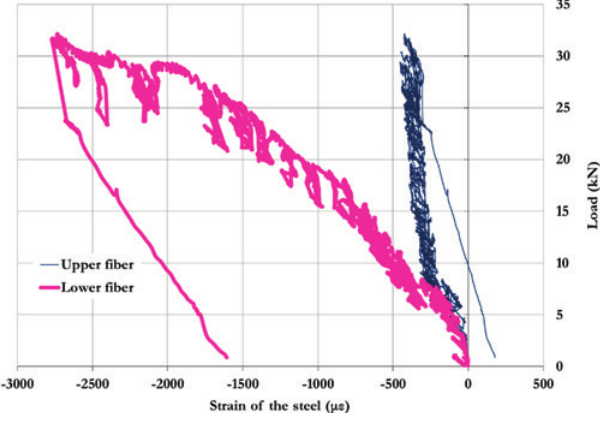
Load versus steel strain curves for specimen 01A